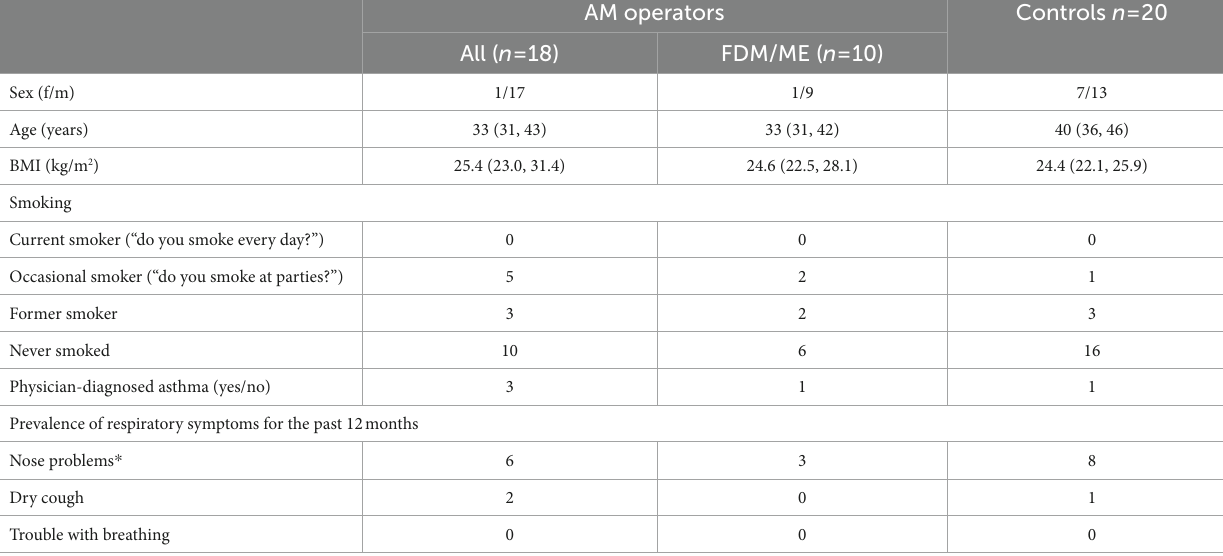
TABLE 1 Characteristics of additive manufacturing (AM) subjects and controls in the